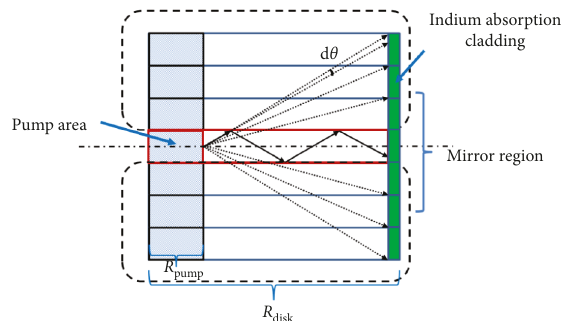
Figure 2: Mirror diagram of fluorescence transmission path in thin disk crystal.